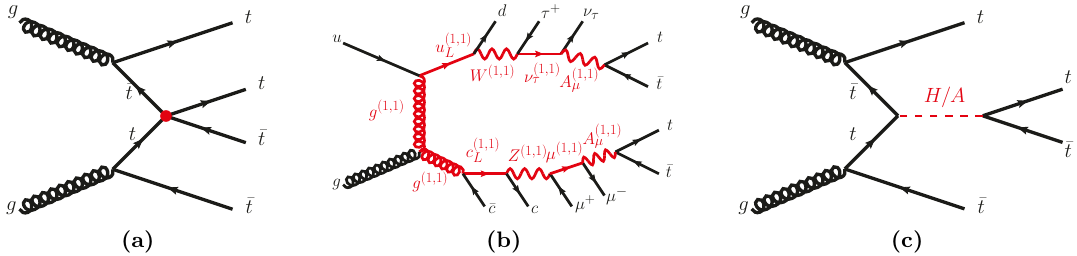
Figure 2 . Three examples of four-top-quark production in the context of (a) a four-fermion contact interaction (CI), (b) two compacti(cid:12)ed universal extra-dimensions (2UED), and (c) two- Higgs-doublet model